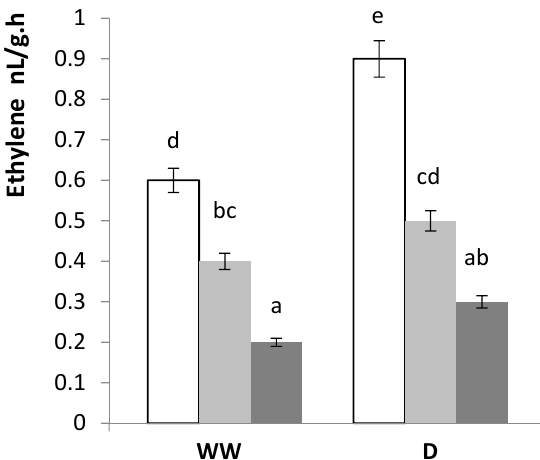
Figure 6. Ethylene content 20 DAS. Data are shown as means ± SD ( n = 3). Means with common letters are not significantly different ( p > 0.05). The plants were cultivated under WW or D conditions. The inoculation * drought interaction p = 0.0297.